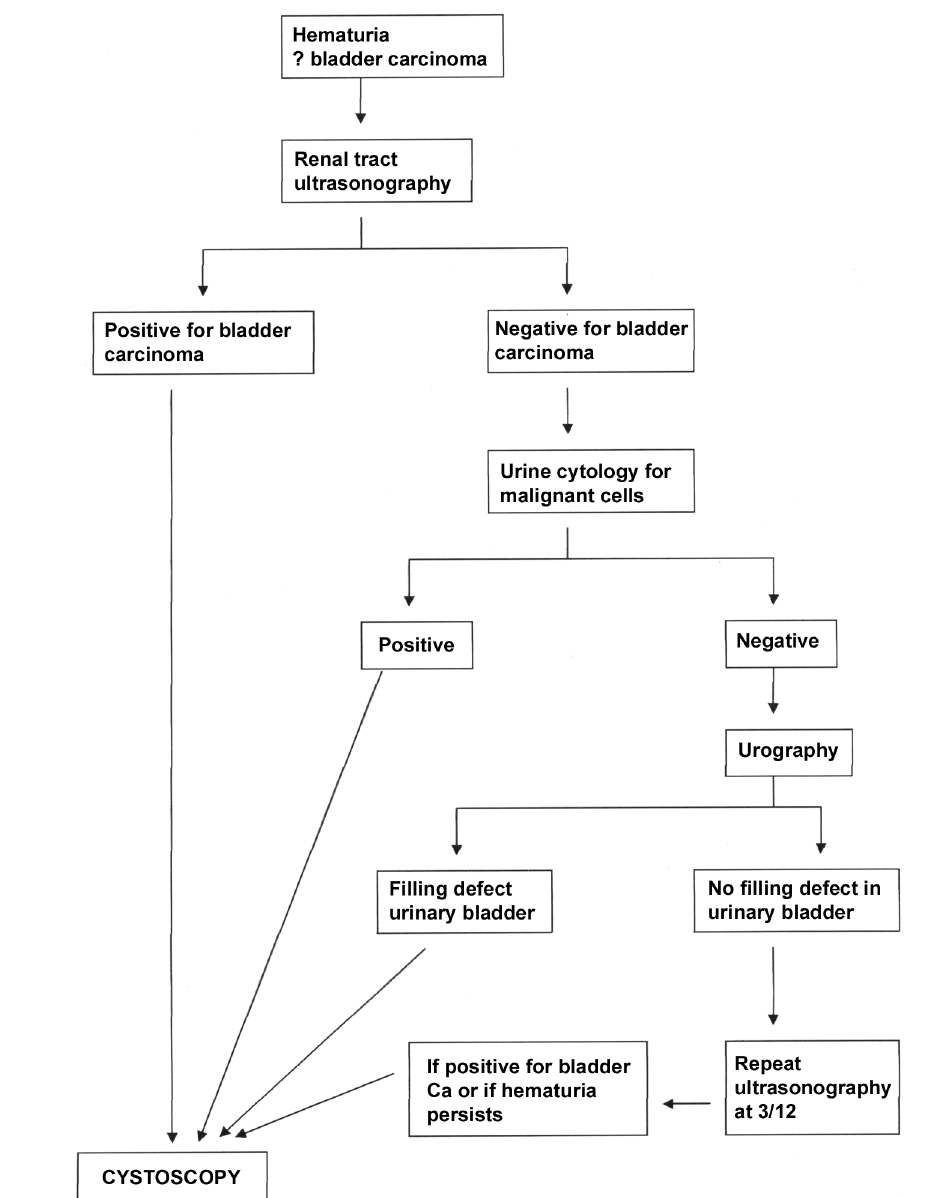
Figure 5 – Flow diagram for investigation of patients presenting with hematuria of suspected bladder carcinoma